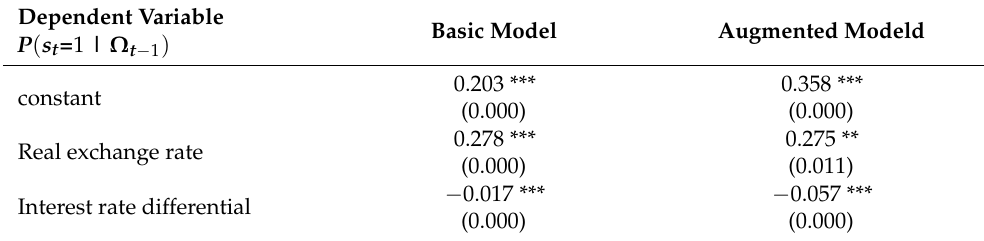
Table 5. Tobit model of ex ante